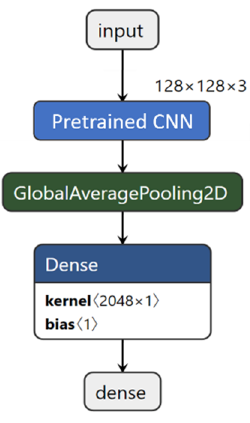
Figure 6. Transfer learning with pretrained convolutional neural network (CNN) architectures. Output from a pretrained CNN was joined to a global average pooling 2D layer and connected to a final dense layer, with the activation function set as either “sigmoid” for image classification or “linear” for image